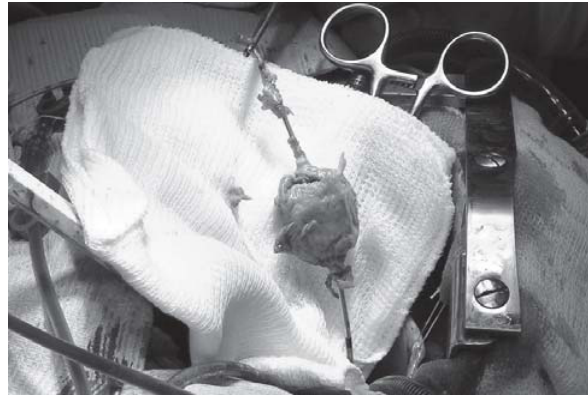
Fig. 2 - There is a large vegetation attached to the ventricular lead into the right atrium without affection of the tricuspid valve